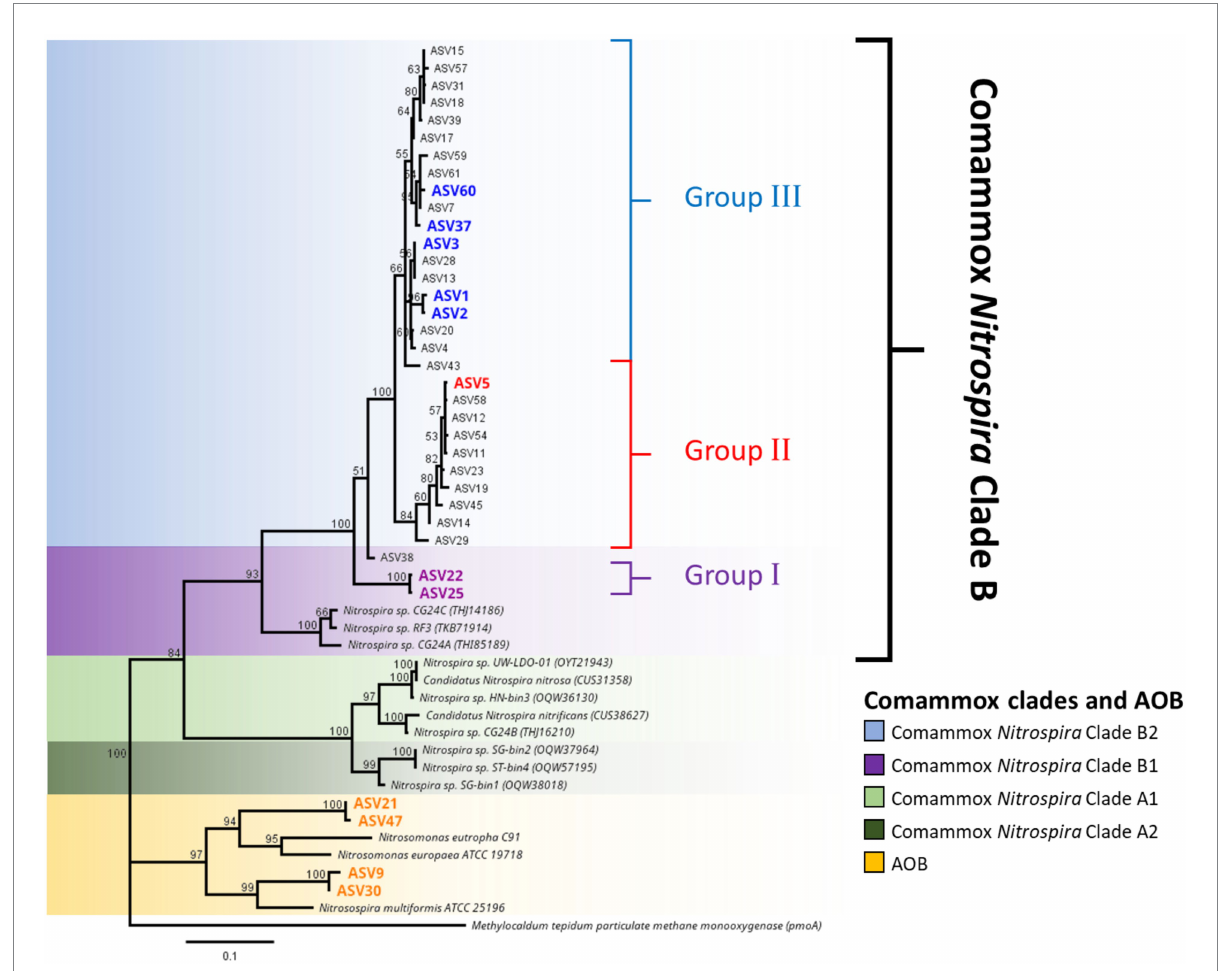
FIGURE 4 Phylogeny of ammonia oxidizing bacteria and comammox Nitrospira amoA sequences. Phylogenetic analysis of comammox Nitrospira amoA from high-throughput sequencing was carried out using maximum likelihood alignment analysis. The genetic distance was calculated using